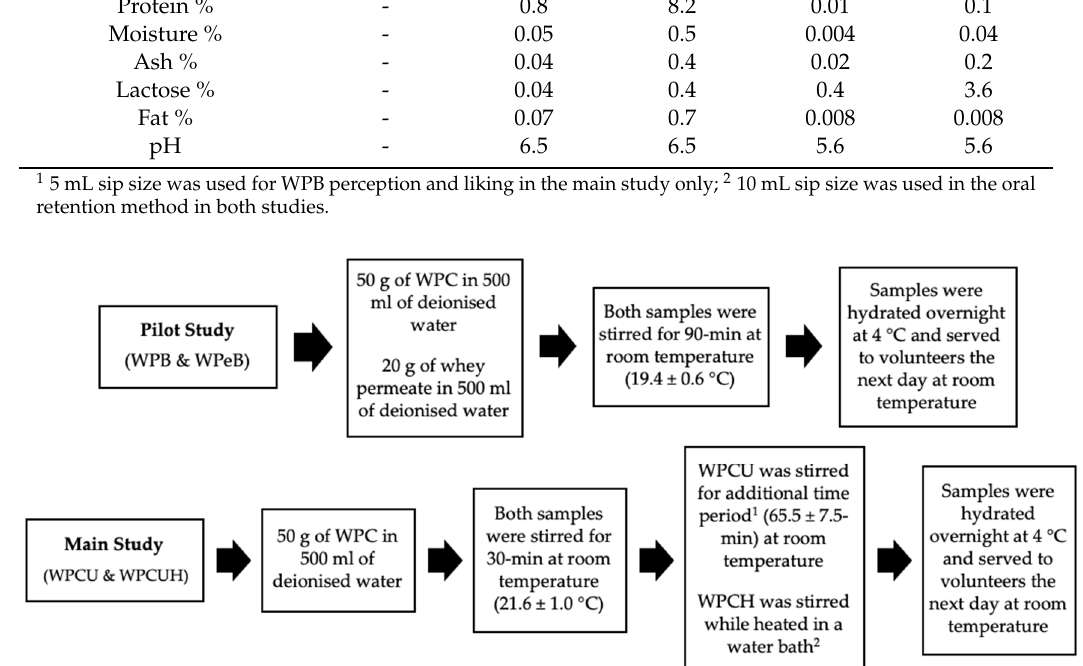
Table 2. Overview of whey protein beverage (WPB, 10% w/v ) and whey permeate beverage (WPeB, 4% w/v ).